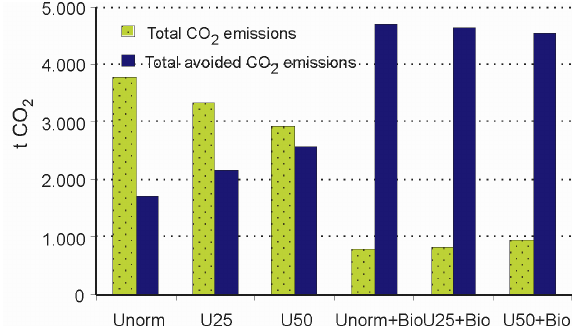
Fig. 2. Environmental efficiency of alternatives